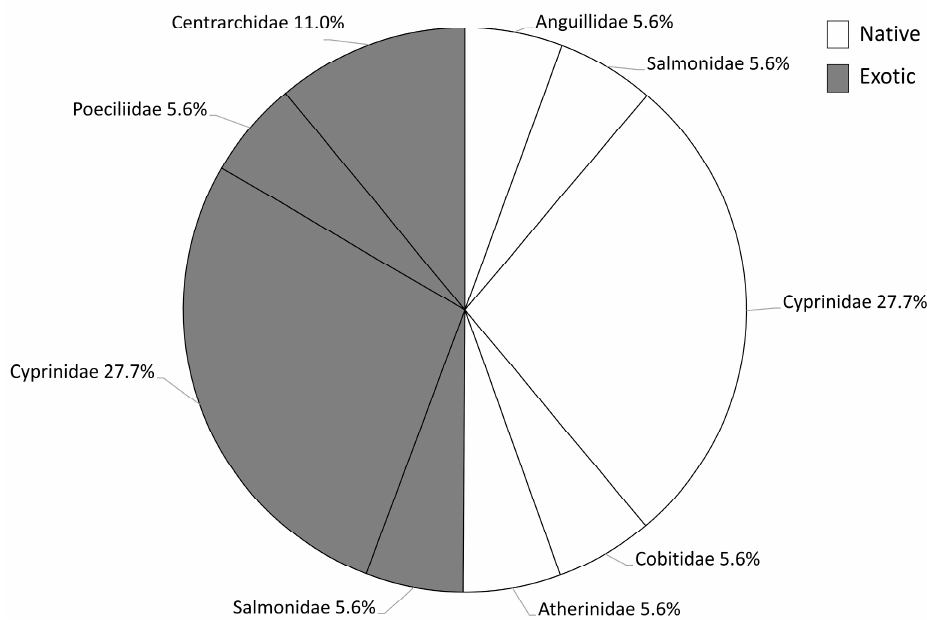
Figure 2. Percent of species number of the total families found in the Guadalquivir River Basin during the sampling sessions. Table 2. Families and number (%) of Iberian freshwater fish species recorded in the Guadalquivir River Basin. Sources: Carta Piscícola Española for Spanish data (http://www.cartapiscicola.es, ac- cessed on 27 September 2022) and Fishbase for Portuguese data (http://www.fishbase.org/Coun- try/CountryChecklist.php?showAll=yes&c_code=620&vhabitat=fresh, accessed on 15 July 2022). * Tinca tinca is considered introduced according [44].